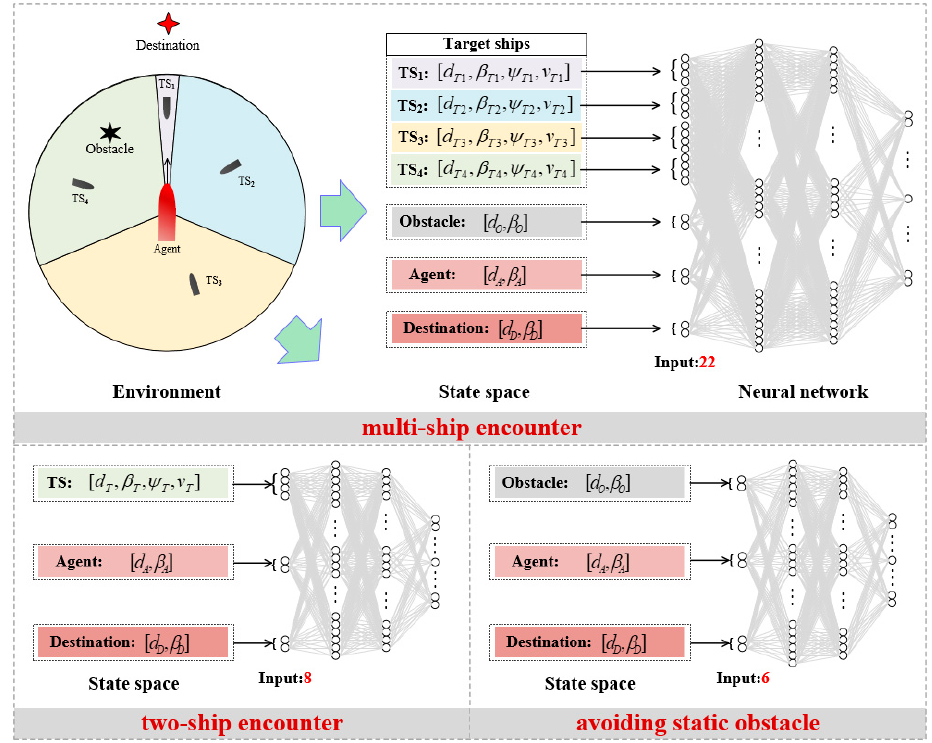
Figure 4. Schematic diagram of state space determination method in different scenarios.